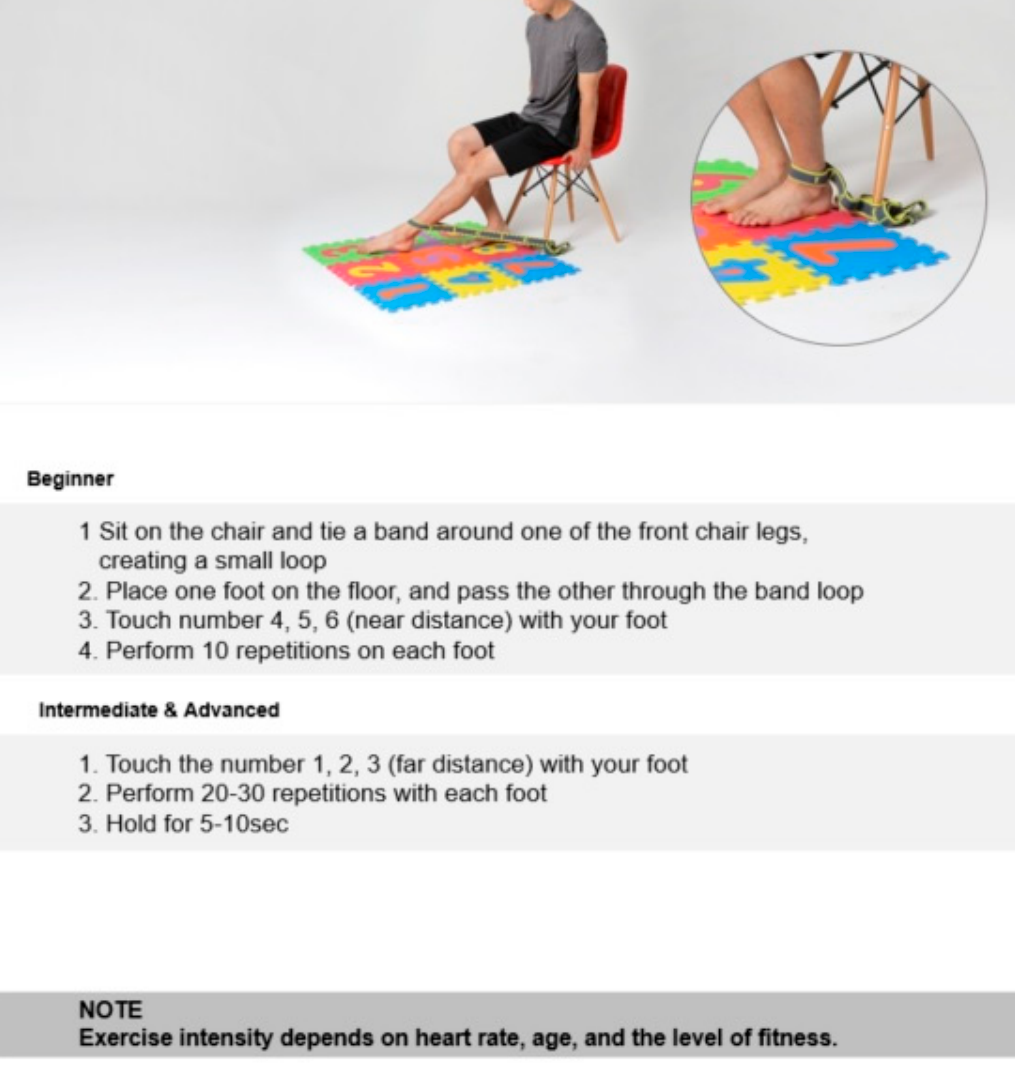
Figure A16. Detailed description and components of each movement in the “Band pull touch” resistance exercise.